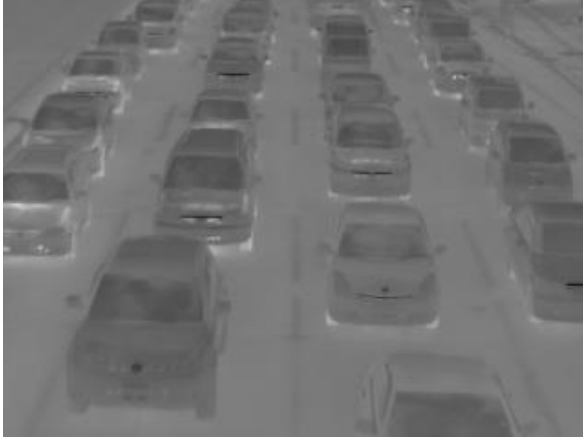
Figure 8. A thermal image in which the temperatures of the windshields similar to those of the exterior of the